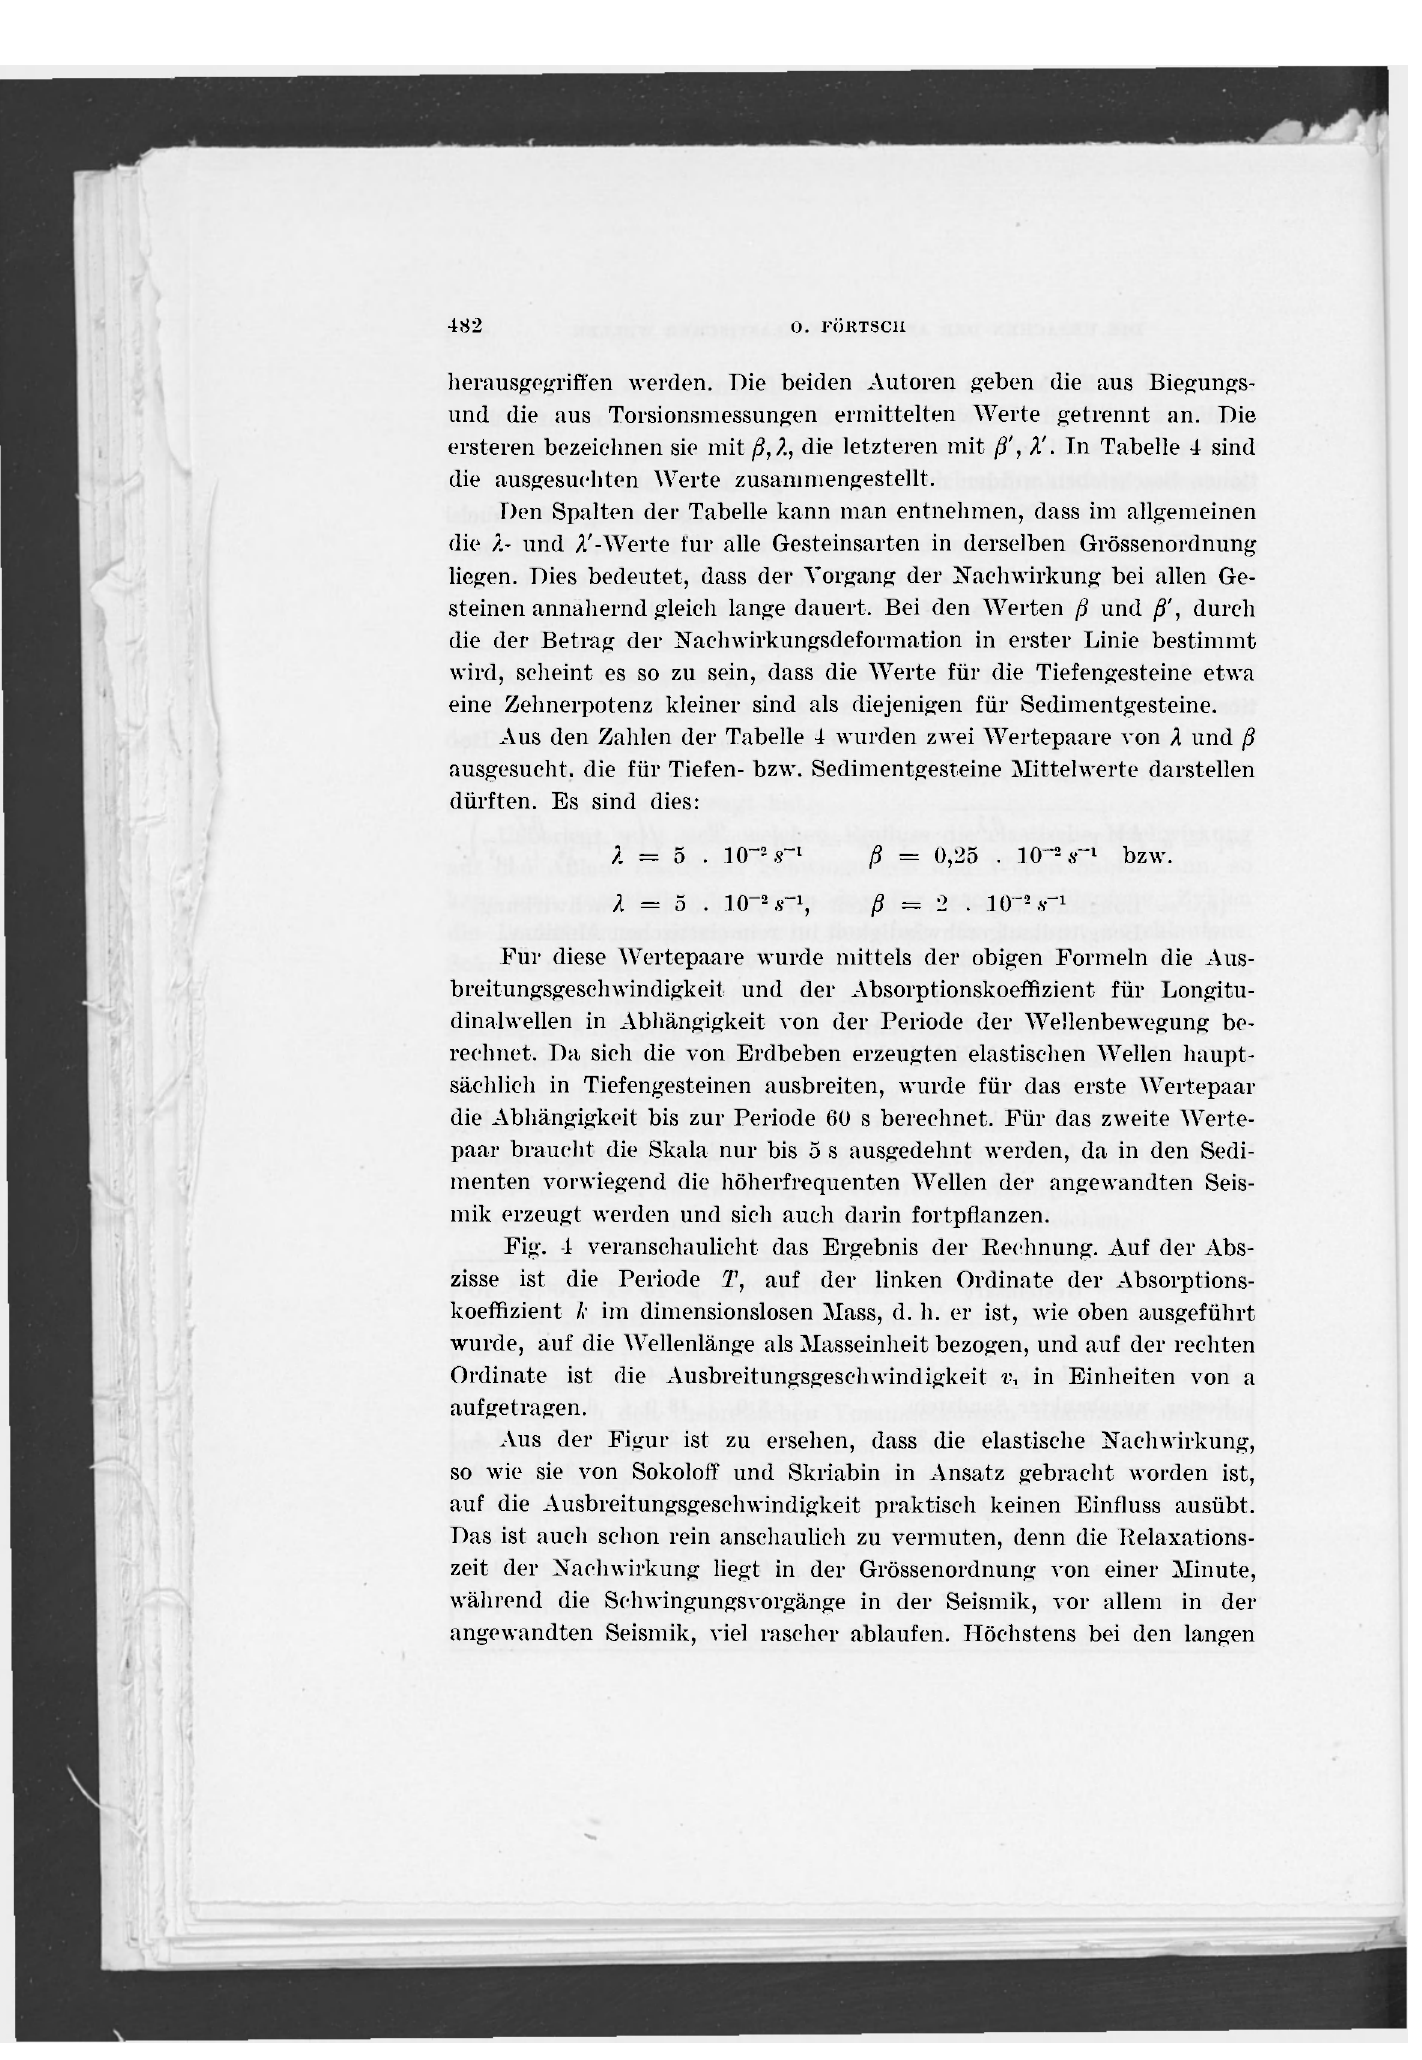
Fig. -1 veranschaubcht das Ergebnis der Rechnung. Auf der Abs- zisse ist die